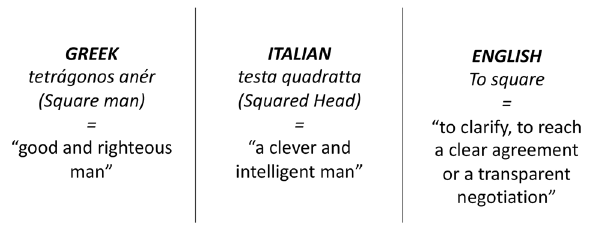
Fig. 2 The meaning of “ square ” in some European languages. (Adapted from Menninger,